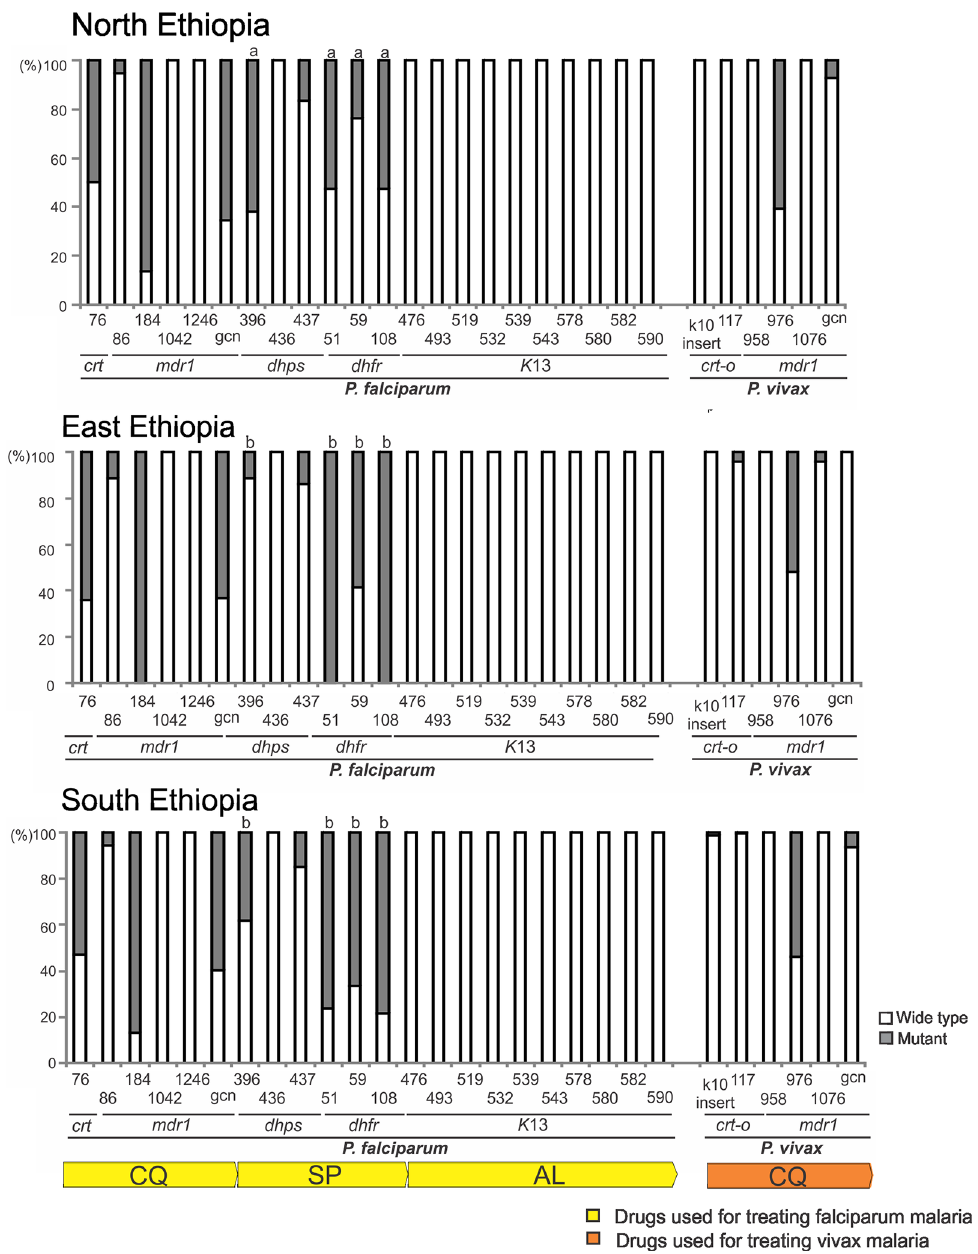
Fig 5. Frequency of mutations in gene codons related to antimalarial drug resistance (bottom bar) among Plasmodium falciparum and P . vivax samples from the north, east, and south Ethiopia. The proportionof wild type (white) and mutants (gray) for each codon positionwas indicatedin each column of the respectiveresistant gene associatedwith the antimalarial drug (bottom bar). GCN denotesgene copy number of pfmdr 1 and pvmdr 1(white: single copy; gray: (cid:21) two copies). Significantdifference was detected in the mutation frequencyof codons in pfdhps and pfdhfr among the study sites, as indicatedby a small letter above the column.